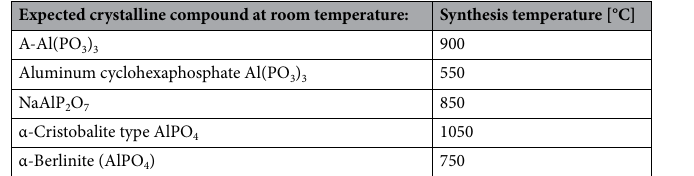
Expected crystalline compound at room